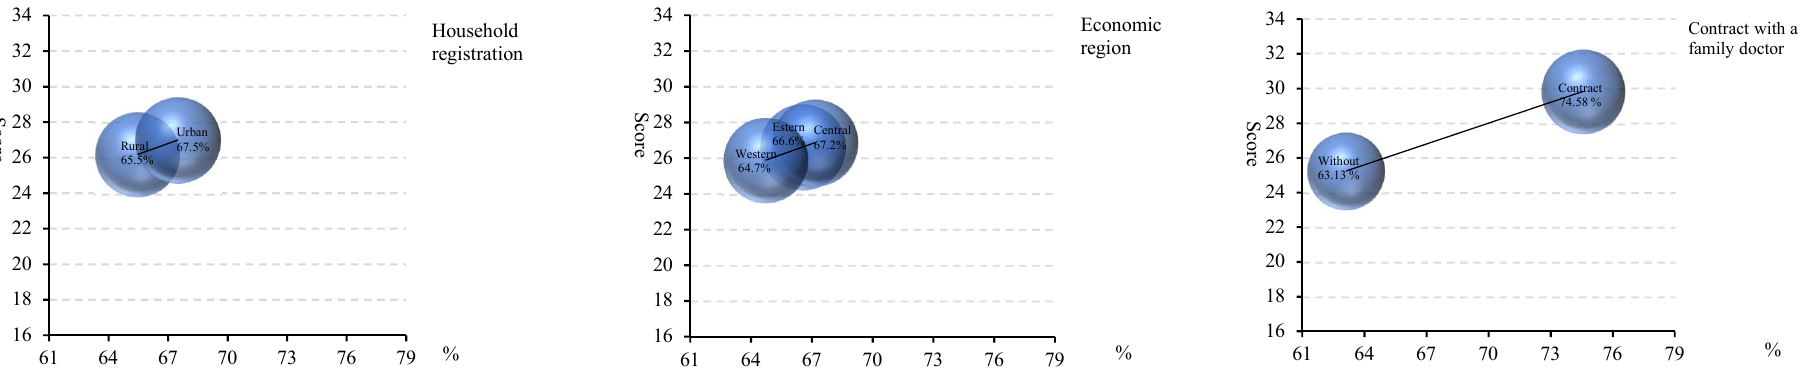
Figure 5. Total perception score on the quality of primary healthcare by household registration, economic region, and whether contracted with a family doctor.